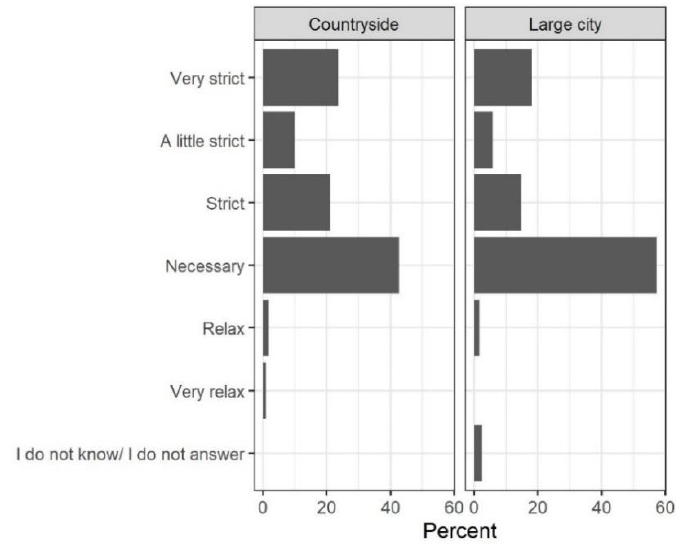
Figure A1. Cross-tabulation of attitudes of believers towards the measures of the state by city (% by city). Χ 2 = 12.72, df = NA, p = 0.037 (Pearson’s Chi-squared test with simulated p -value based on 2000 replicates).